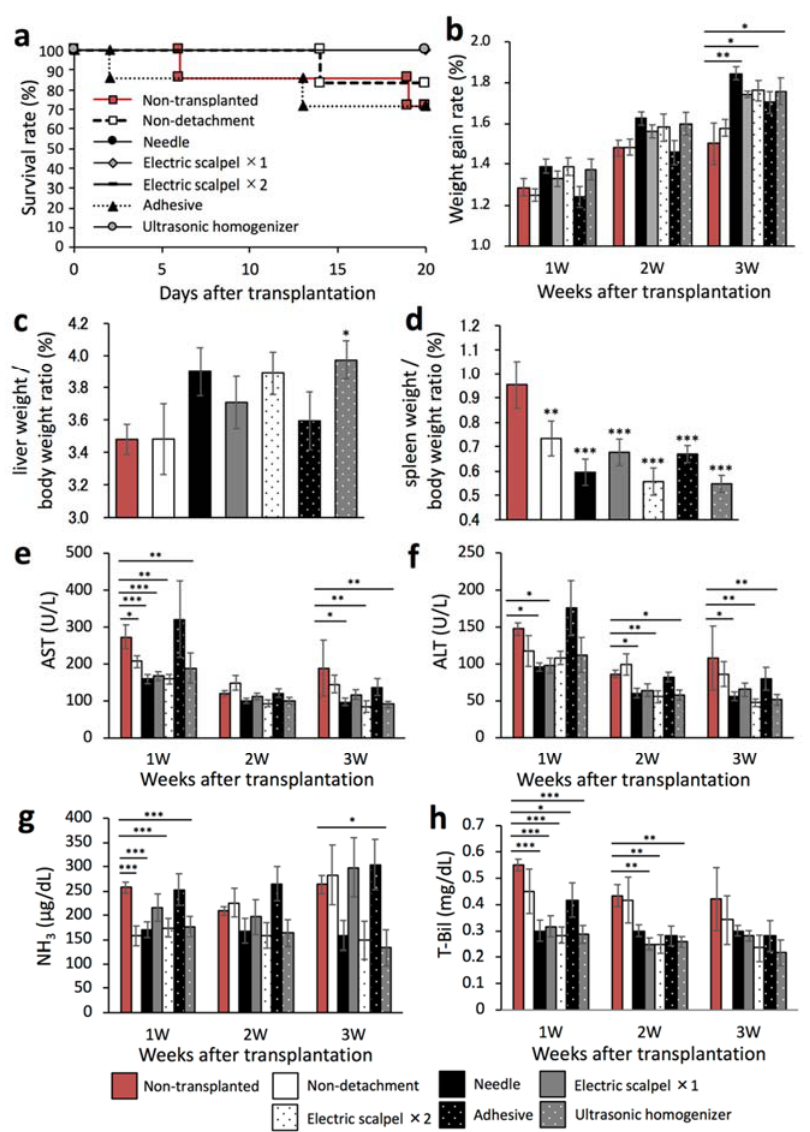
Figure 4. Evaluation of the therapeutic effect of fetal livers transplanted using different detachment methods. ( a ) Survival rates of the rats after transplantation (non-transplanted, n = 6; non-detachment, n = 6; needle, n = 7; electric scalpel × 1, n = 6; electric scalpel × 2, n = 6; adhesive, n = 7; ultrasonic homogenizer, n = 7). ( b ) Rate of weight gain after transplantation (non-transplanted, n = 7; non- detachment, n = 6; needle, n = 7; electric scalpel × 1, n = 6; electric scalpel × 2, n = 6; adhesive, n = 7; ultrasonic homogenizer, n = 7). ( c , d ) Three weeks after transplantation, liver and spleen were removed and weighed to determine liver/body weight ratio and spleen/body weight ratio (non- transplanted, n = 7, non-detachment, n = 6, needle, n = 7, electric scalpel × 1, n = 6, electric scalpel × 2, n = 6, adhesive, n = 7, ultrasonic homogenizer, n = 7). ( e – h ) At 1, 2, and 3 weeks after transplantation, plasma AST ( e ), ALT ( f ), NH 3 ( g ) and T-Bil concentrations ( h ) were measured (non-transplanted, n = 7; non-detachment, n = 6; needle, n = 7; electric scalpel × 1, n = 6; electric scalpel × 2, n = 6; adhesive, n = 7, ultrasonic homogenizer, n = 7). The data are shown as the mean ± Standard error. * p < 0.05, ** p < 0.01, *** p < 0.001 versus non-detachment group by non-repeated measures analysis of variance with Bonferroni